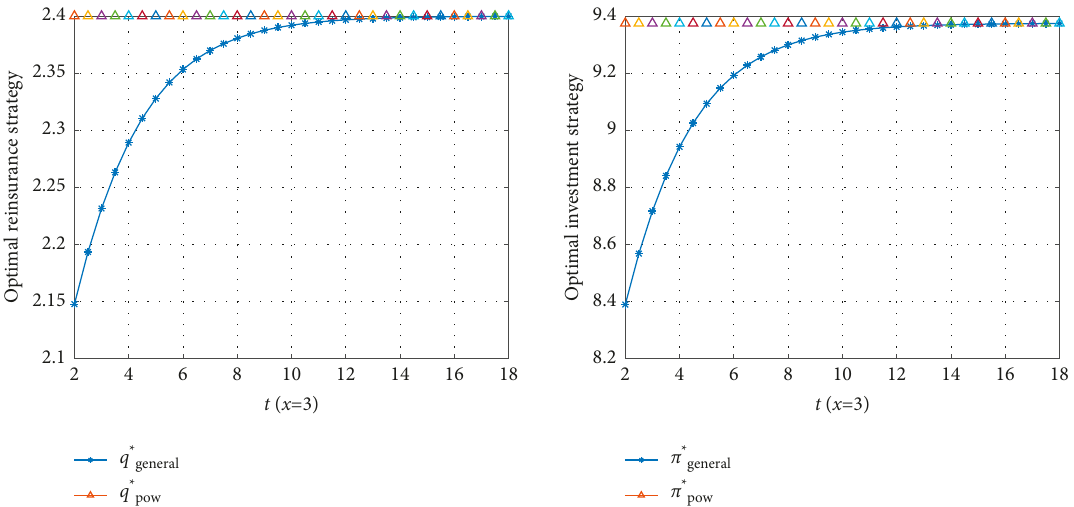
Figure 1: Impacts of ( t ) on optimal strategies with ( x ) � 5.